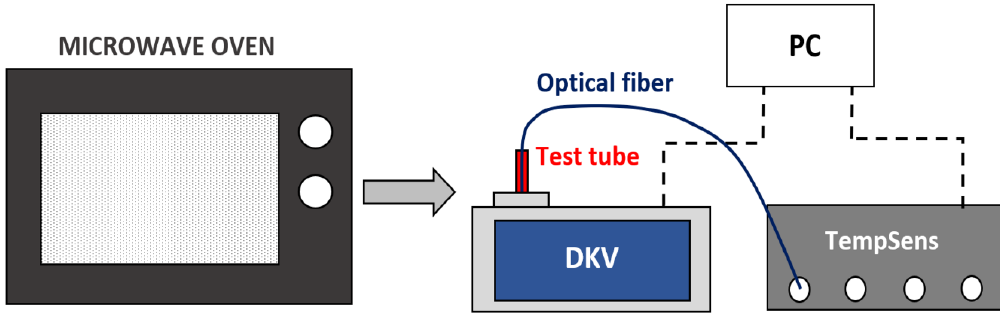
Figure 2. Setup used for measuring the permittivity complex dependence on temperature.